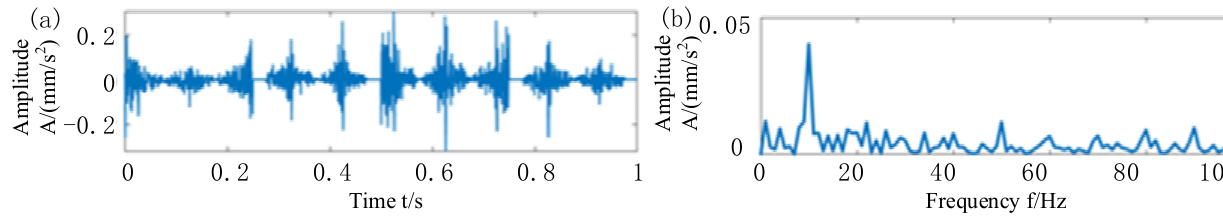
Figure 13. The original K-SVD algorithm to denoise the filtered signal. ( a ) Time-domain waveform of the denoised signal; ( b ) denoised signal envelope spectrogram.